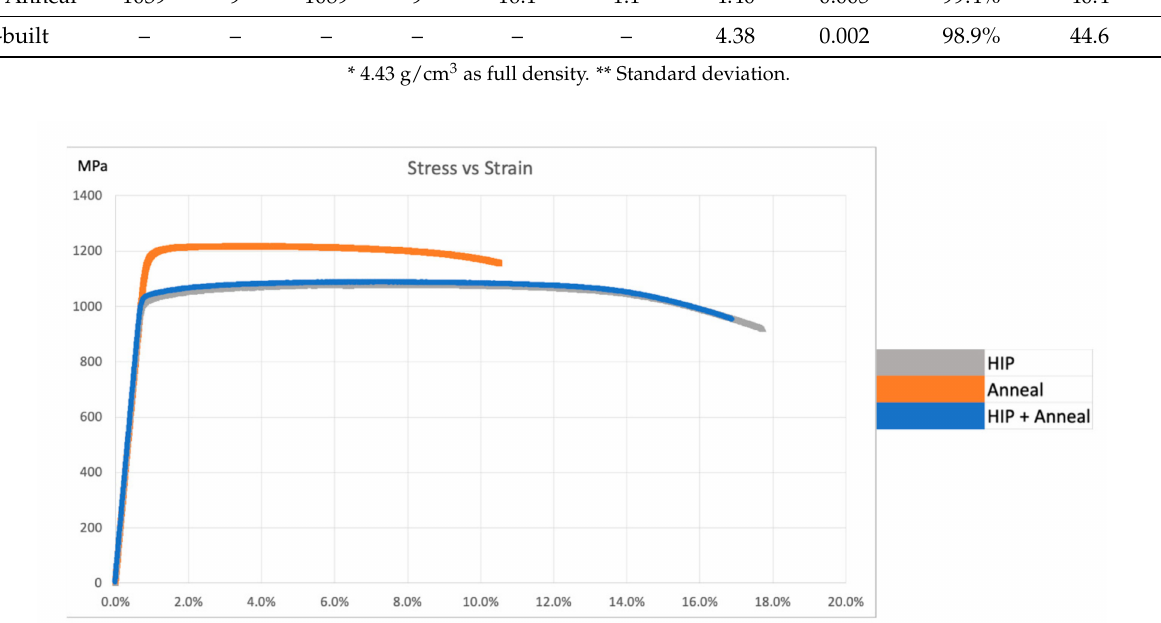
Figure 11. Stress vs. strain curves of individual samples closest to the average.